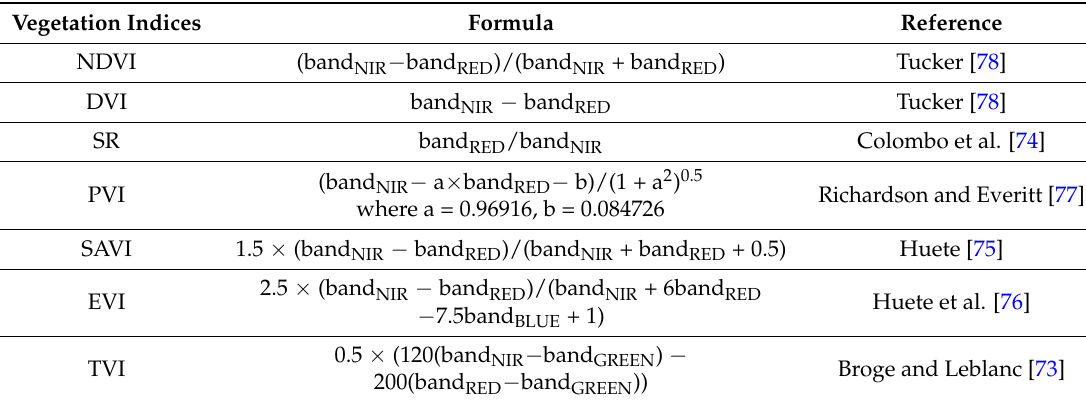
Table 4. Vegetation indices derived from TM